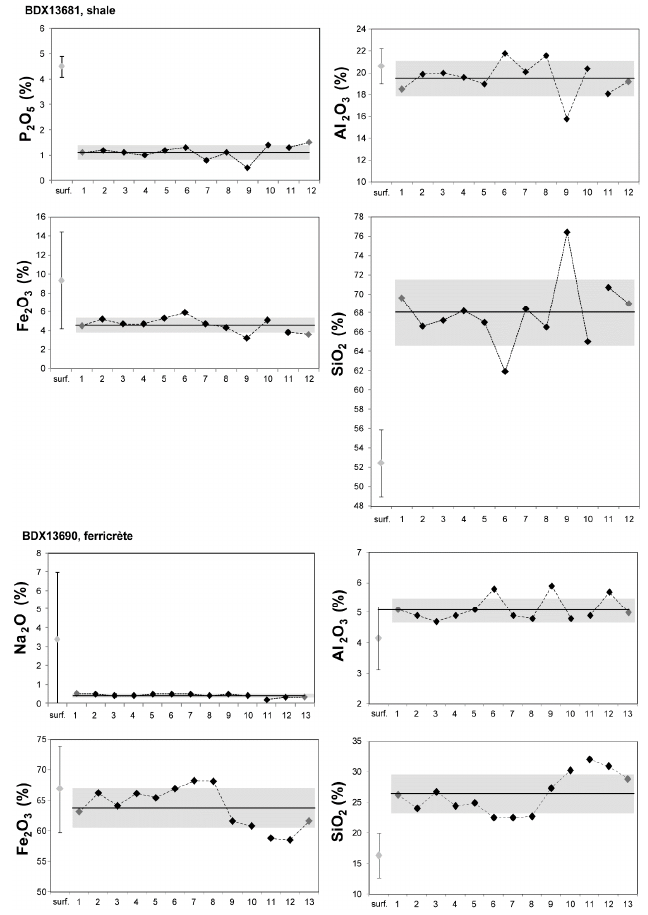
Figure 4. Main EDXS results of two archeological pieces, a shale (13681) and a ferricrete (13690): comparison between the surface and the section. Diamonds in light gray: average with standard deviation calculated from six measures on the surface. Diamonds in dark gray: edges of the section. Diamonds in black: inside of the section. The black line represents the average from the measurements on the section and the gray area the standard deviation. Legend—Surf.: Surface.